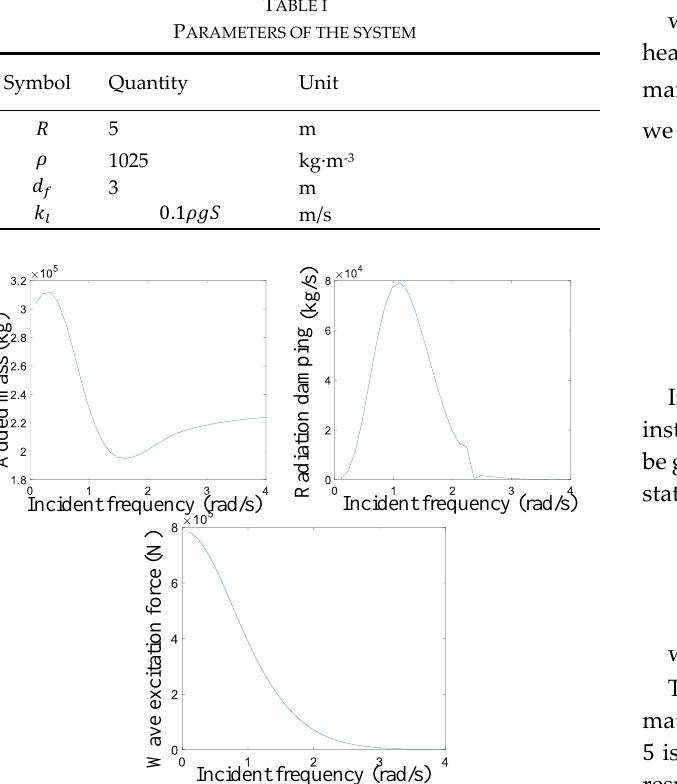
Fig. 2. Hydrodynamic coefficients of floating in heave direction.